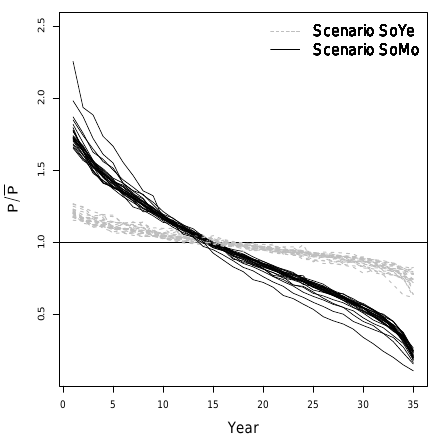
Figure 2. Precipitation ratios of the annual precipitations P and the long-term mean precipitation P for scenarios SoYe and